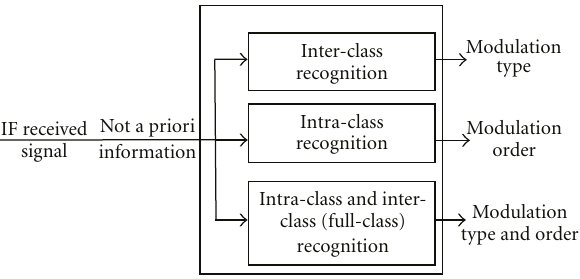
Figure 8: Modulation recognition scenarios including inter-class, intra-class, and full-class recognition.